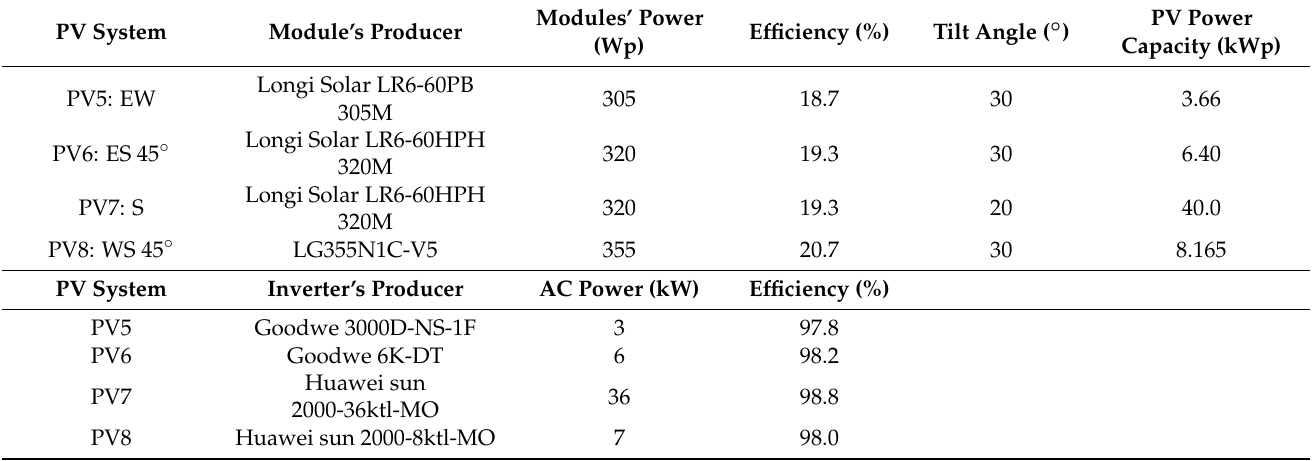
Table 2. Main electrical parameters of the PV modules used in PV5–PV8 installations and system orientation